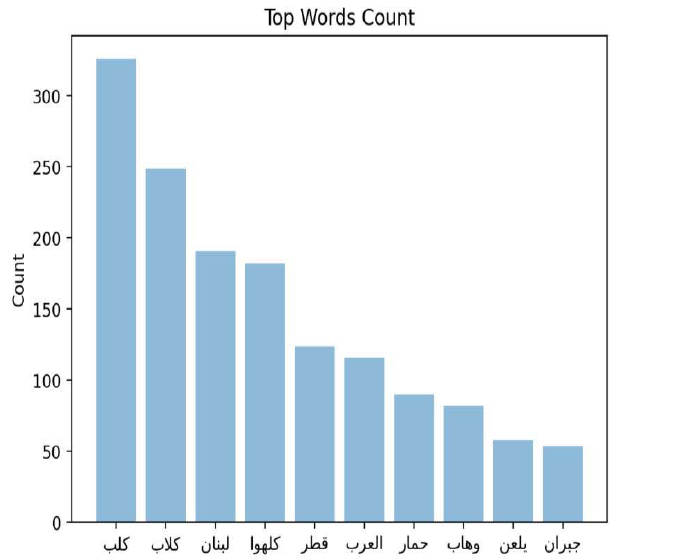
(cid:73)(cid:46) (cid:202)(cid:191) : (cid:9)(cid:225)(cid:170)(cid:202)(cid:75)(cid:10) :